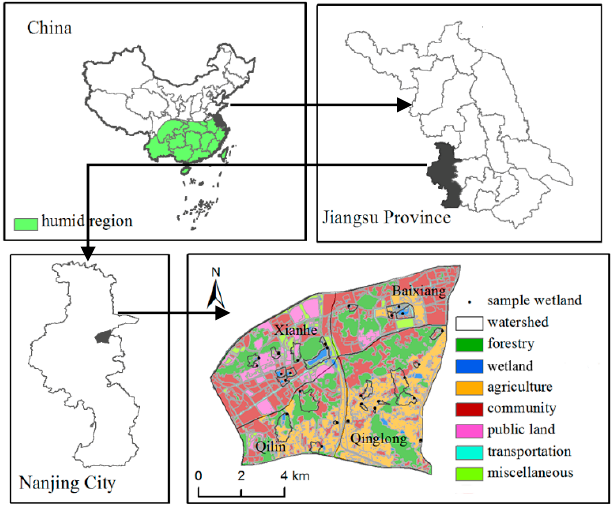
Figure 3. Location of the study area, land-use categories, and sample locations in the Xianlin sub-city. Table 3. Area of total wetlands and selected sampling points in the four sub-regions.